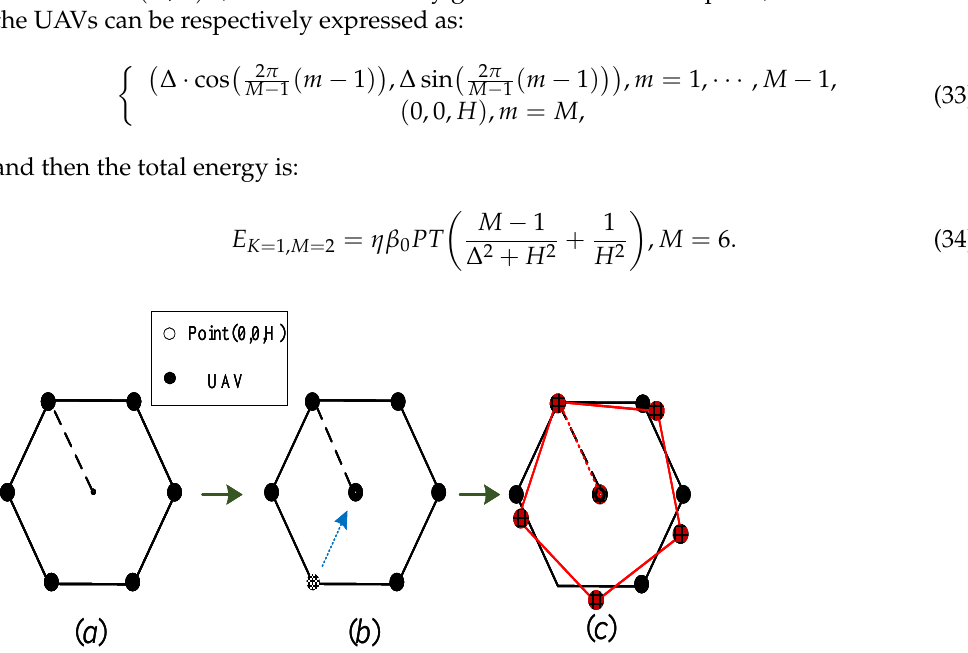
Figure 5. The optimal trajectory of UAVs in the scenario of K = 1 and M =